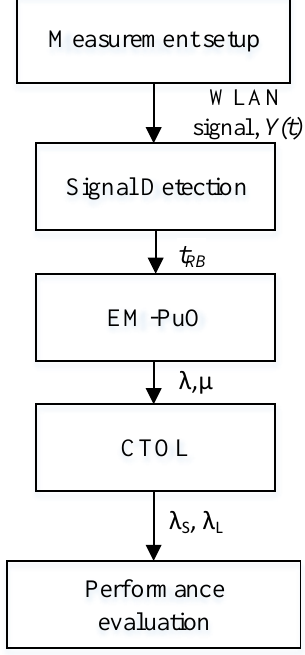
Figure 1. Flow chart of the CTOL